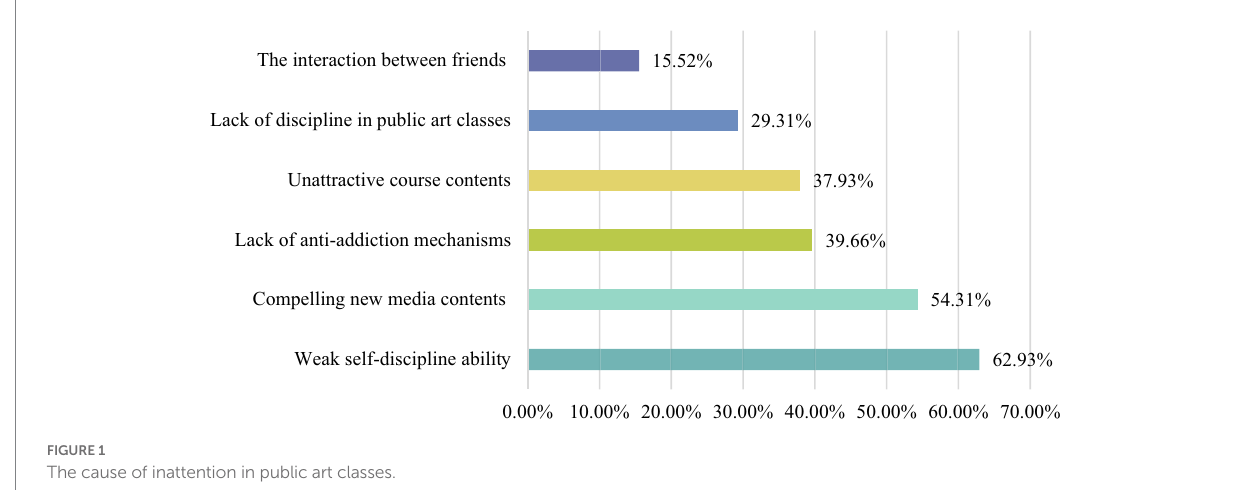
FIGURE 1 The cause of inattention in public art